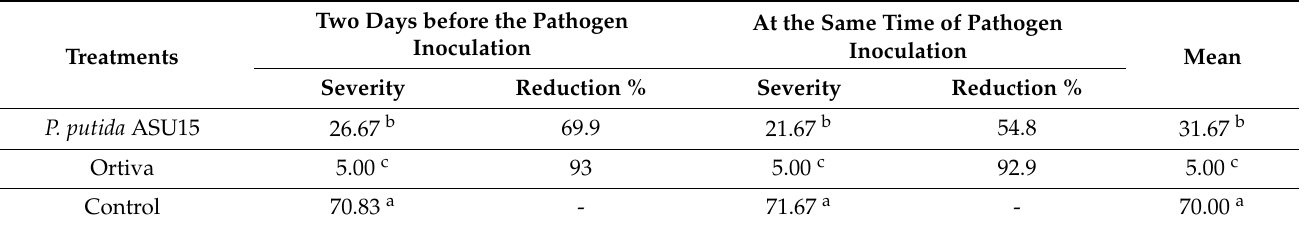
Table 4. Inhibitory effect of Pseudomonas putida strain ASU15, as a foliar treatment, on disease severity of common bean rust under greenhouse